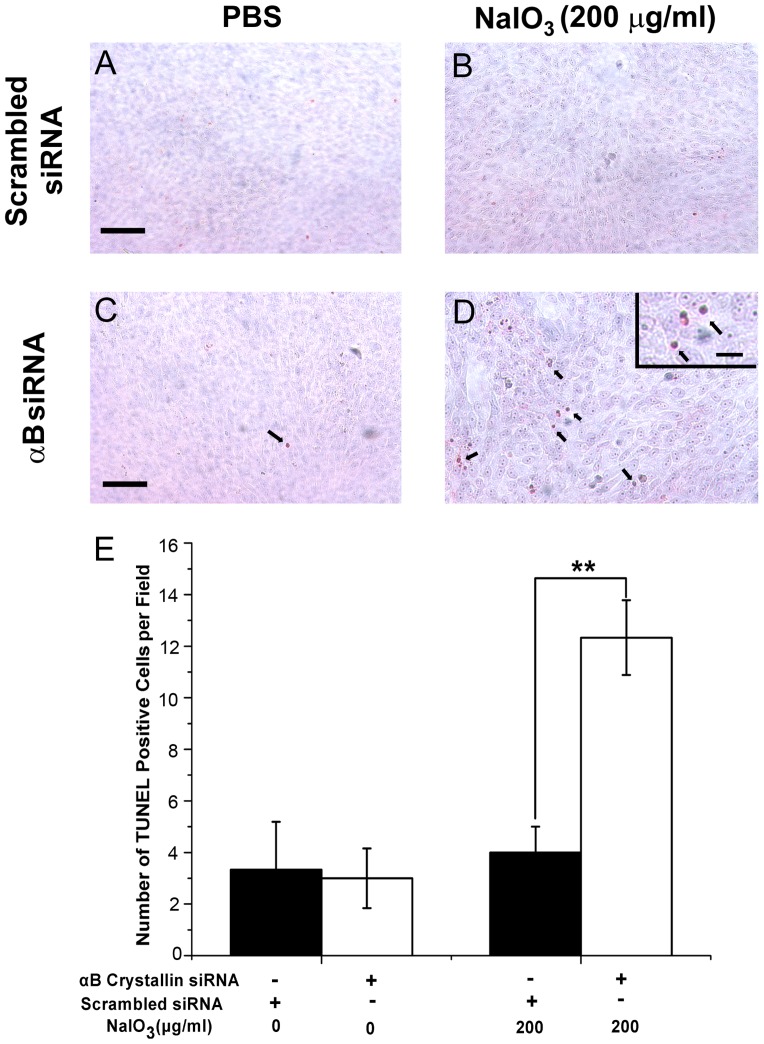
Induction of apoptosis in RPE cells with low dose of NaIO3.Forty-eight hours after scrambled siRNA or αB crystallin siRNA transfection, human RPE cells were treated with 200 µg/ml NaIO3 for 24 hours. TUNEL staining was performed in scrambled siRNA-transfected human RPE cells (A, B) and αB crystallin siRNA-transfected human RPE cells (C, D). Treatment with NaIO3 resulted in increased TUNEL-positive cells with αB crystallin siRNA-transfection as compared with scrambled siRNA controls. (arrows in inset in D and E). Data are mean ± SEM from three individual experiments, αB siRNA refers to αB crystallin siRNA. **P<0.01. Scale = 40 µm for A–D and 10 µm for inset in D.